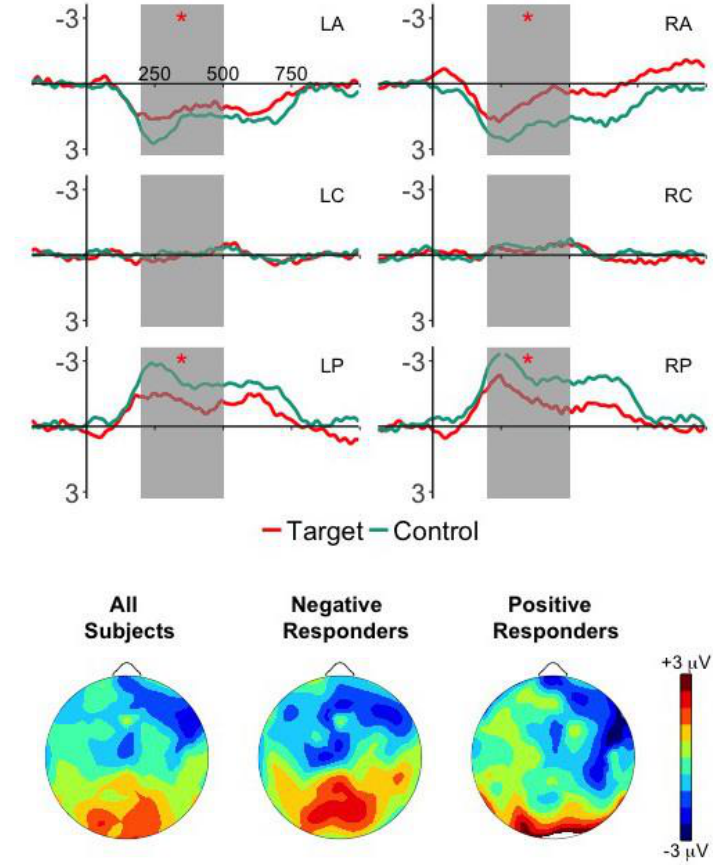
Figure 3. ( a ) Grand-average event-related potentials (ERP) responses time-locked to word onset for the target and control words presented in the Test Phase for the 6 ROIs: left anterior (LA), right anterior (RA), left central (LC), right central (LR), left posterior (LP), right posterior (RP). The time window of interest, 200–500 ms is highlighted in gray and significant effects are marked as * p < 0.05. ( b ) Mean distribution plots for the ERP effect of word familiarity in the Test Phase (target—control words) in the 200–500 ms time window for overall group performance (left), Negative Responders (central), and Positive Responders (right).